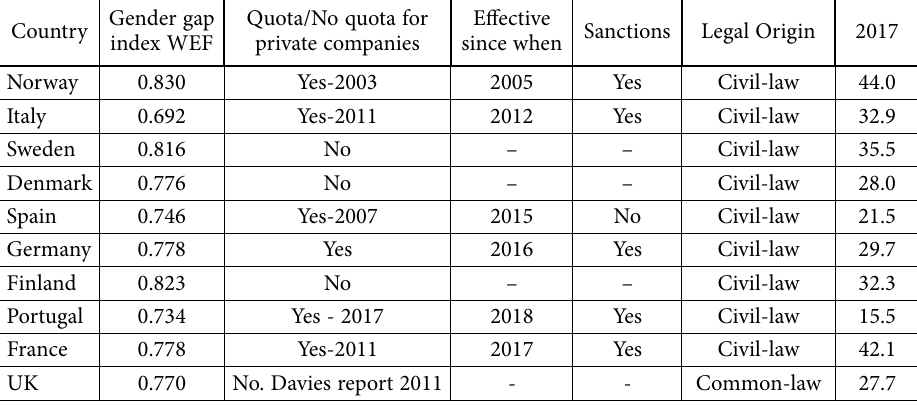
Table 1. Gender diversity gap and quotas Gender gap Country index